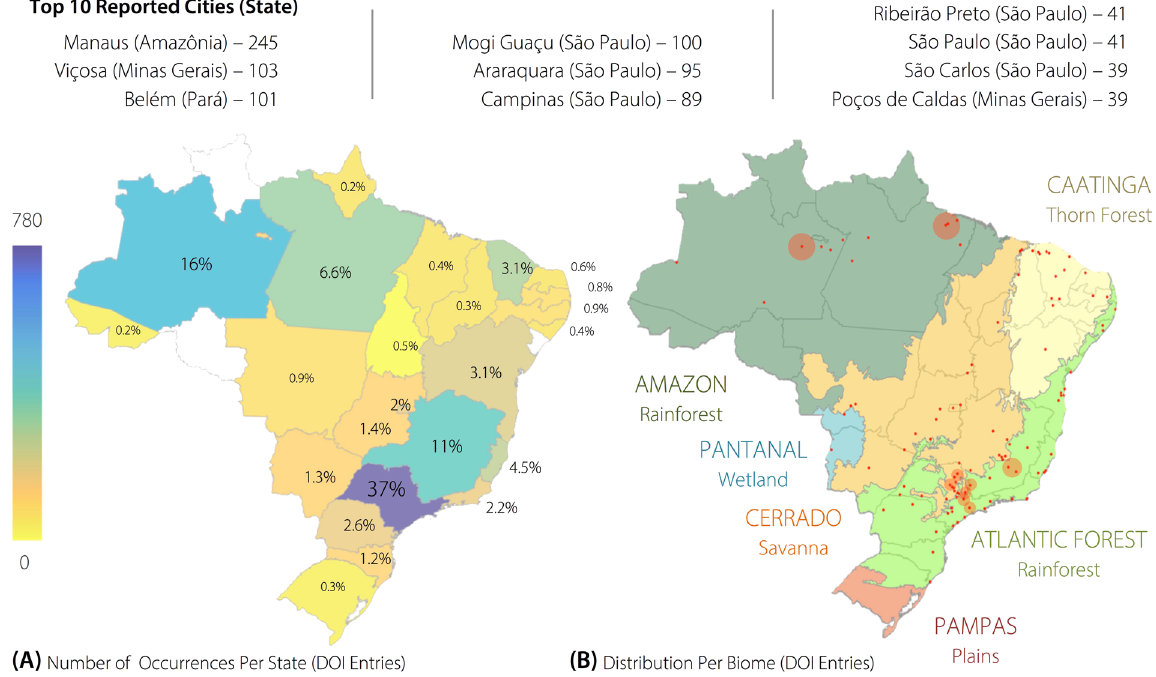
Figure 3. Representation of the distribution of NuBBE DB compounds in Brazilian territory and its biomes. ( A ) Distribution of the species from which compounds in the NuBBE DB were identified for each Brazilian State. ( B ) Species from which the compounds in the NuBBE DB were identified are from all six different Brazilian biomes (the red dots represent the cities where these species were collected). The ten most frequently reported cities (upper part) are denoted in ( B ) as a red shadow (the size corresponds to the number of occurrences). Software used to create the map: Matlab R2016b (Mathworks, MA,